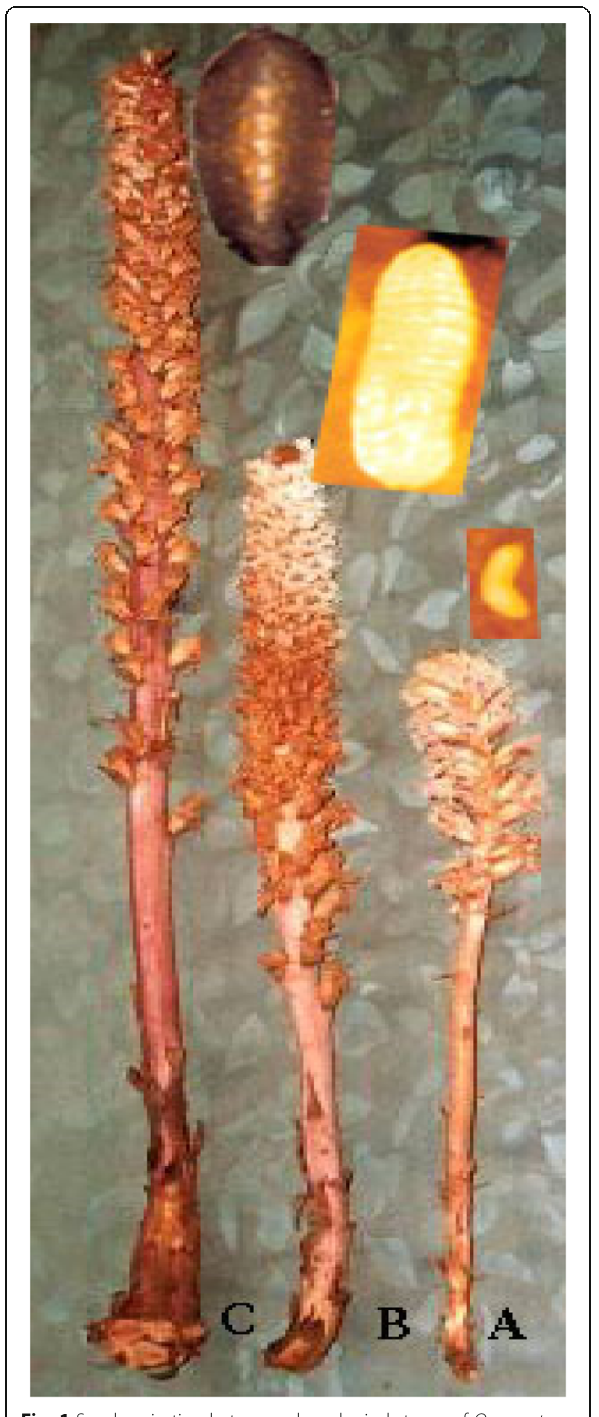
Fig. 1 Synchronization between phonological stages of O . crenata and immature stages of P .